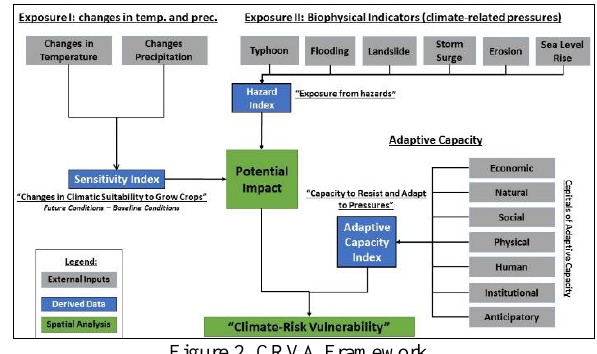
Figure 2. CRVA Framework.